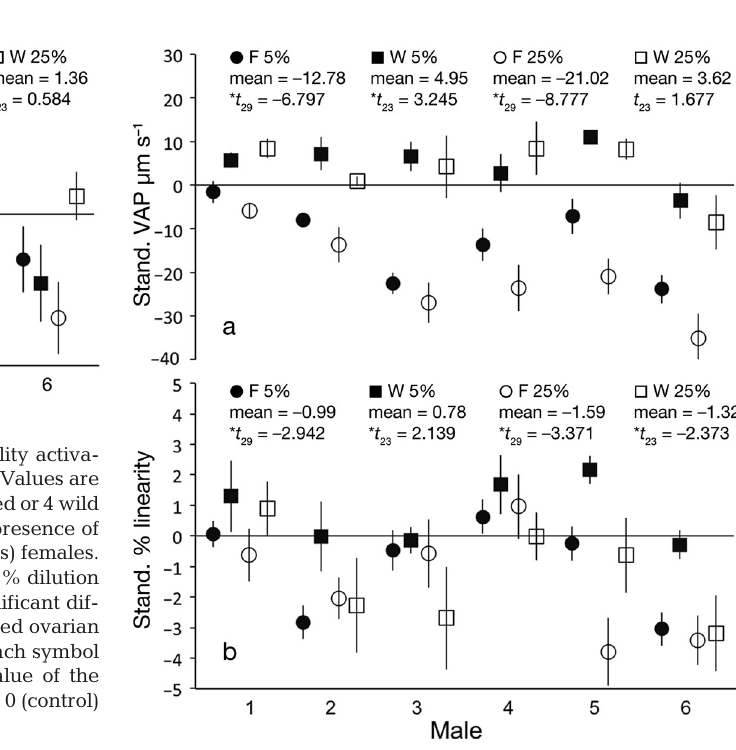
Fig. 3. Mean (a) sperm velocity (VAP) and (b) linearity 10 s after motility activation standardized to the seawater control (Expt 1). Values are means (±1 SEM) of the ovarian fluids for the 5 farmed or 4 wild females. The symbols are sperm acti- vated in the presence of the ovarian fluid of wild (squares) or farmed (circles) females. The closed and open symbols stand for 5 and 25% dilution of ovarian fluid in seawater, respec- tively. Below each symbol legend is the mean for the 6 males and the t values of the 1-sample t -tests; *results differing significantly from 0